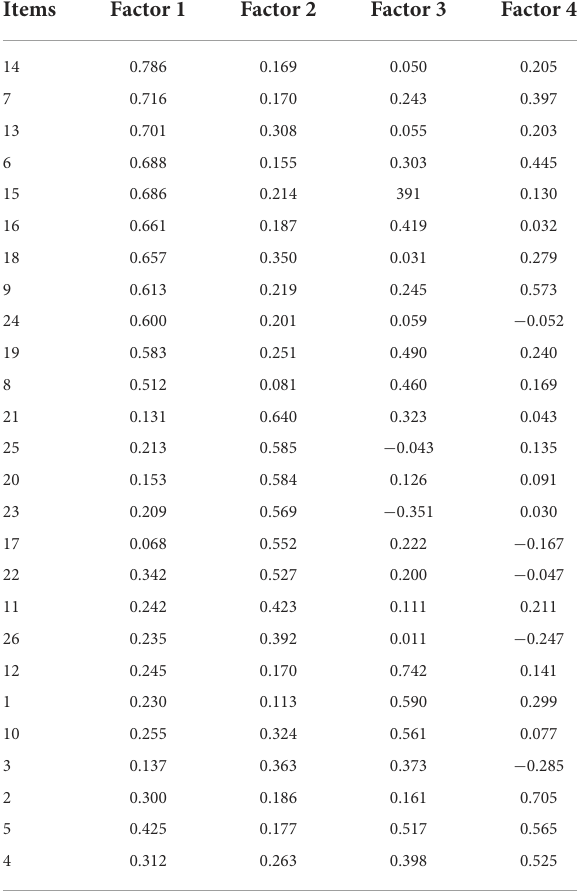
TABLE 2 Rotated factor matrix for PCA of the translated